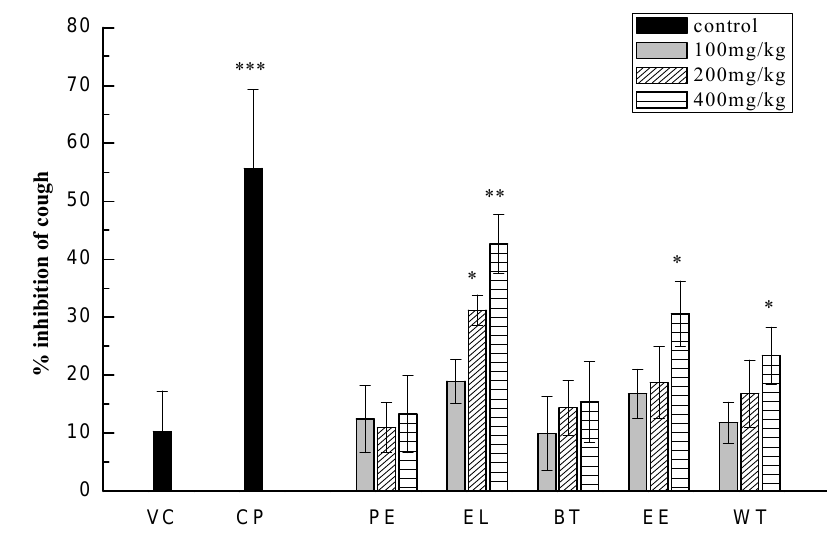
Figure 2. Cough inhibition of vehicle control (VC), positive codeine phosphate (CP), PEF (PE), EtOAcF (EL), n -BuOHF (BT), EtOHE (EE), WE (WT) at 100 mg/kg, 200 mg/kg, 400 mg/kg (i.g). **P < 0.01, *P < 0.05, n =